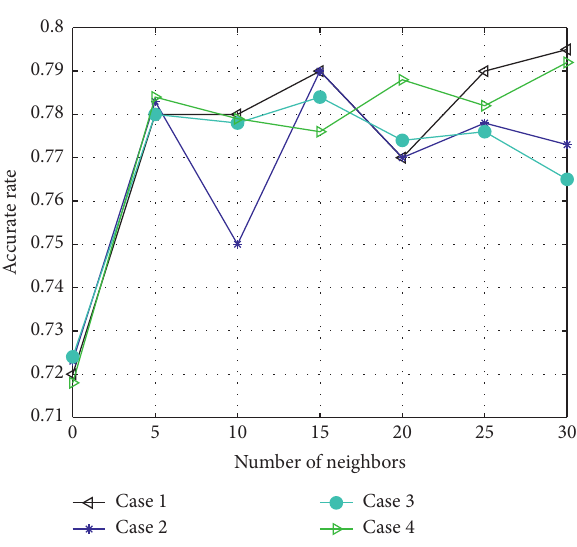
Figure 6: Precise rate diagram.